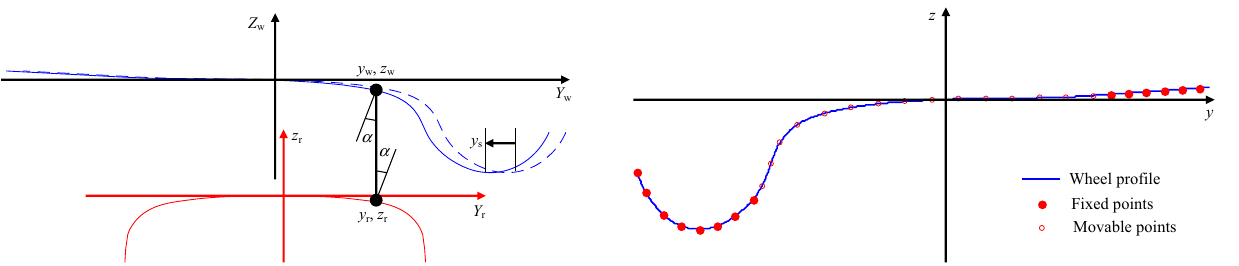
Fig. 1 Sketch of contact points between the wheel and rail